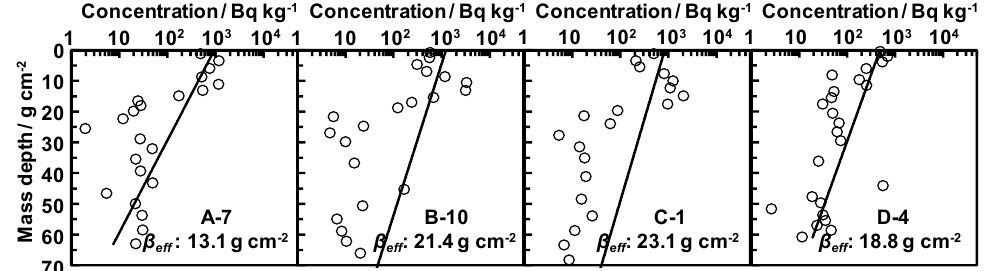
Figure 7. Vertical distributions of the activity concentrations of radiocesium with mass depth (wet weight) and approximate curves.